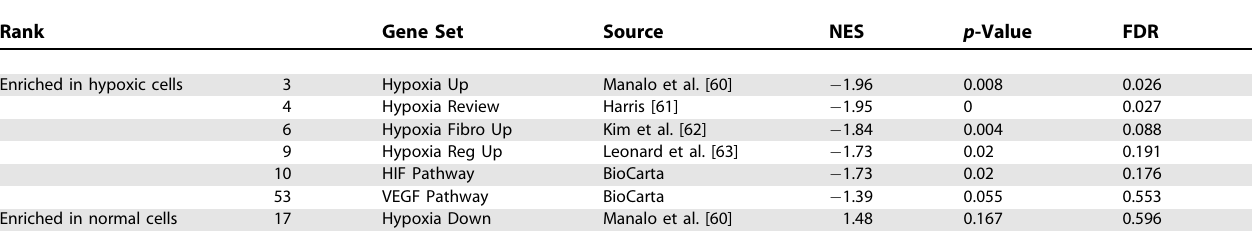
Table 3. GSEA Results for the Hypoxia Gene Sets in the Hypoxia/Normal Dataset